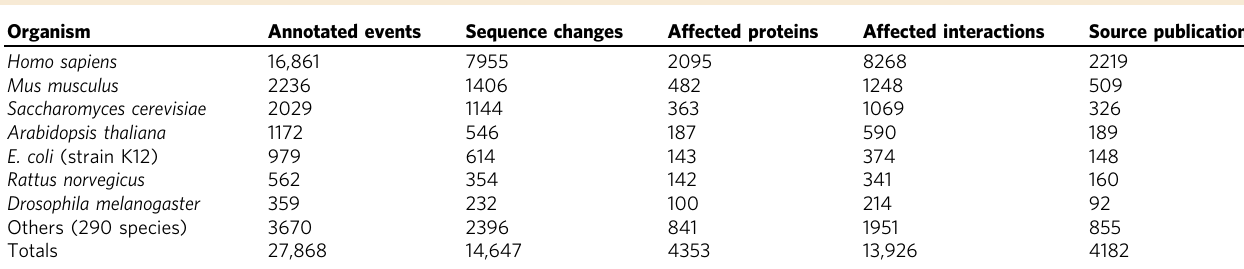
Table 2 Summary statistics per organism